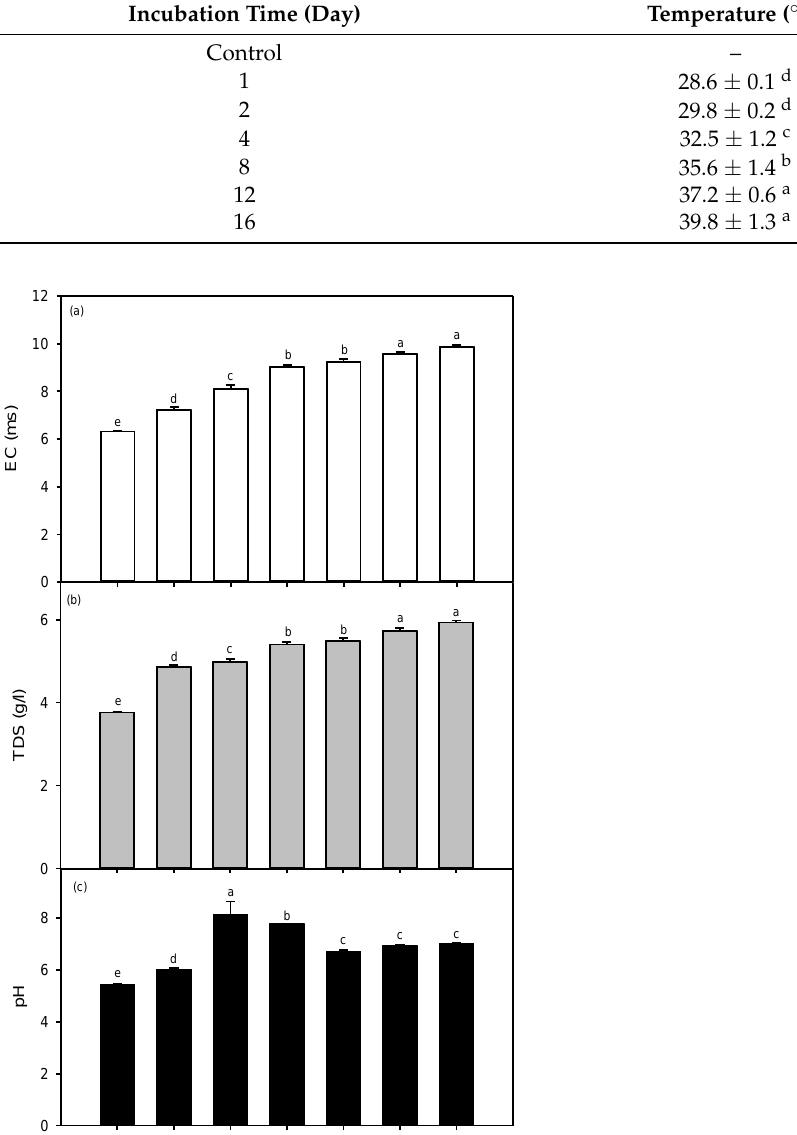
Table 3. Temperatures for the six anaerobic digestion incubation time periods (1, 2, 4, 8, 12, and 16 days). Different letters indicate temperature that are significantly different ( p < 0.05).